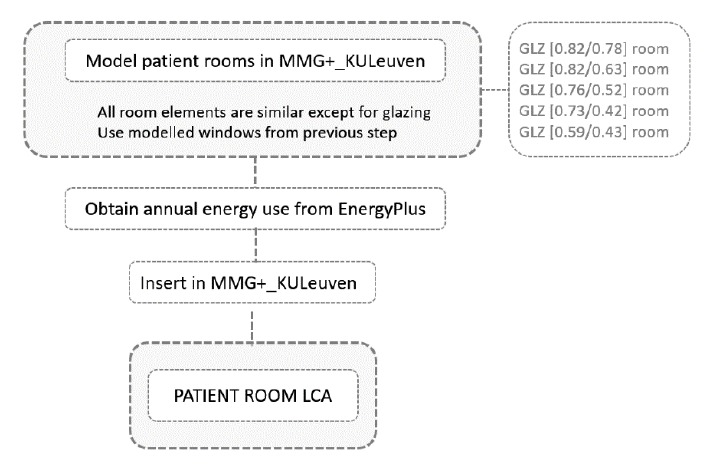
Fig. 3 Patient room LCA